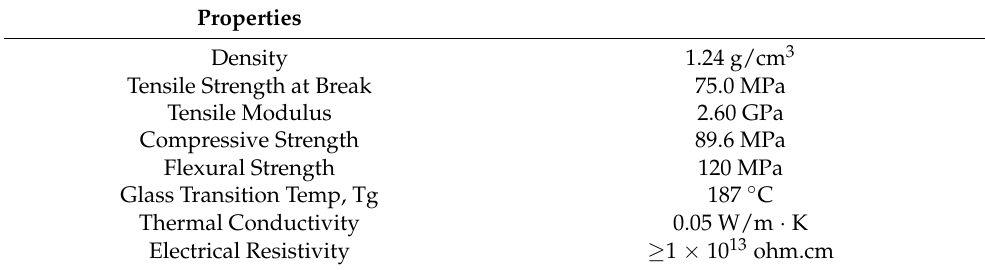
Table 1. Properties of PSU Ultrason S